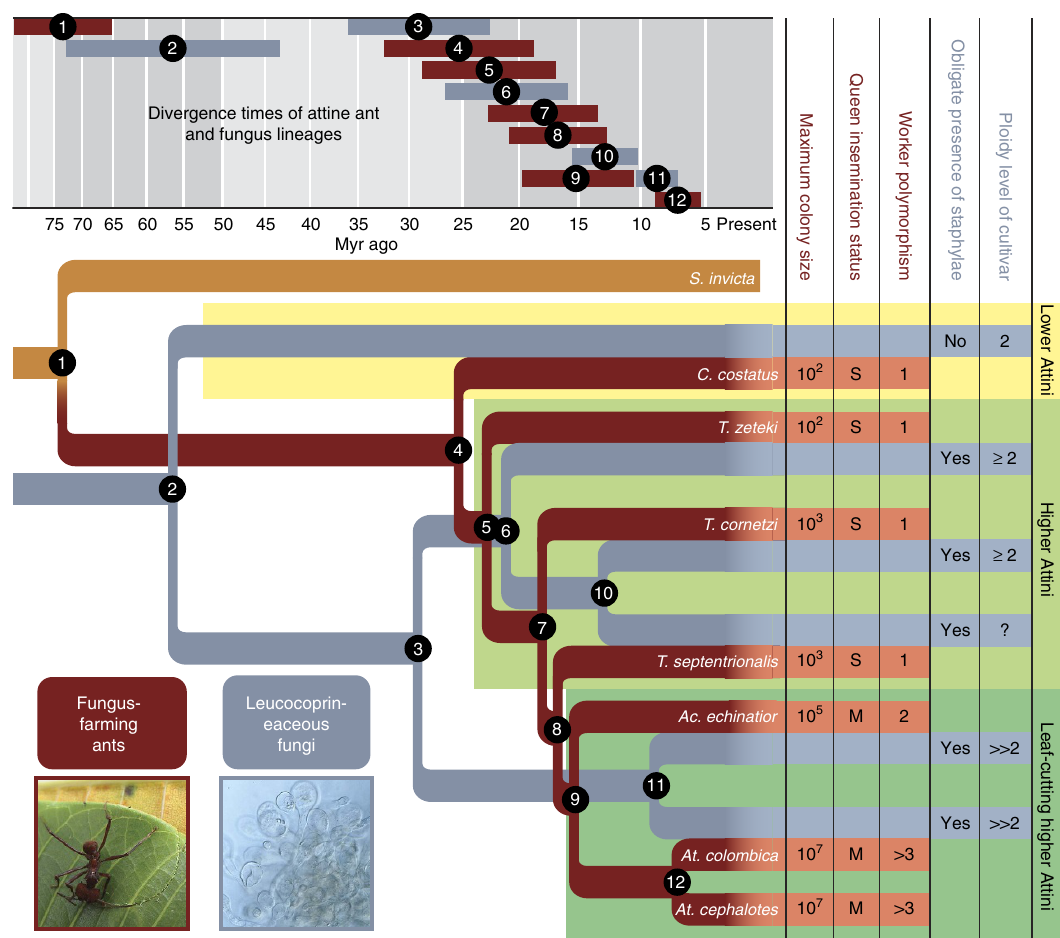
Figure 1 | Time-calibrated phylogeny of attine ants and mutualistic fungal cultivars. The ant phylogeny (brown, attine ants in red brown) is genome- based, whereas the cultivar phylogeny (grey) is derived from transcriptomic data. A. cephalotes and A. colombica share the same fungal symbiont species L. gongylophorus 70 . Only the closest sequenced outgroup, the fire ant S. invicta , is depicted. Full phylogenies including additional ant and free-living fungal outgroups are given in Supplementary Figs 8–11. Error bars (top) indicate minimum and maximum time estimates. The character matrix (right) summarizes key morphological, behavioural and life-history traits across the three major agricultural transitions (yellow, light green and darker green background). Approximate maximum colony sizes are given as powers of 10; queen-insemination status as singly mated (S) or multiply mated (M) 13 ; worker caste polymorphism as 1 (monomorphic), 2 (dimorphic: small and large workers) and 4 3 (polymorphic, including also a morphologically distinct soldier caste) 9 . Lower attine cultivars are simple dikaryotic mycelia (ploidy 2), whereas fully domesticated higher attine cultivars have polynucleate cells with marginal degrees of genetic chimerism (2 o n o 3) or substantial chimeric allopolyploidy (5 o n o 7) (ref. 14). See Supplementary Methods for details. Photographs: Atta leaf-cutting behaviour (D.R.N.) and a fungal staphyla with gongylidia (courtesy J.T.